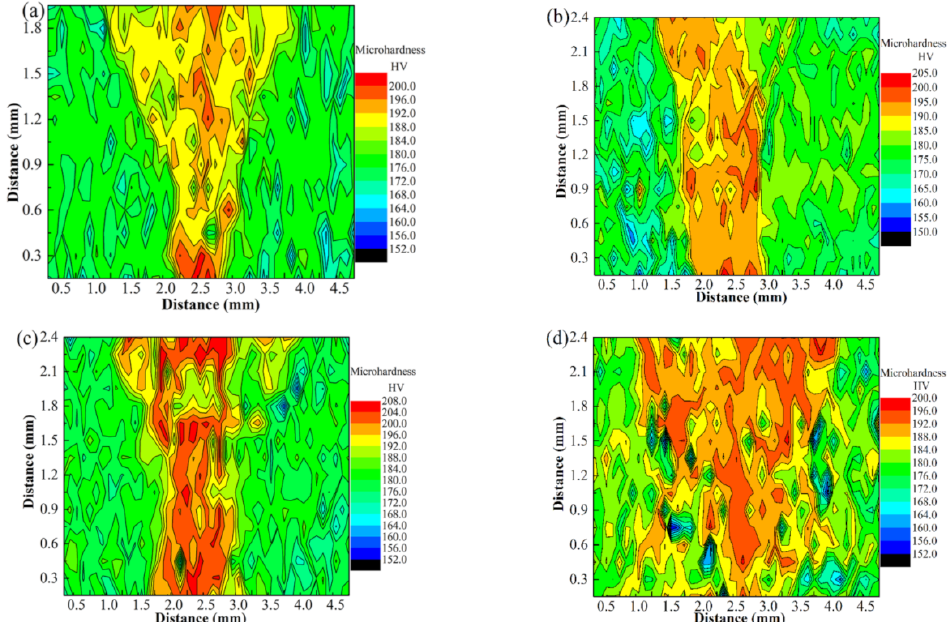
Figure 12. The microhardness distribution maps of the CoCrCuFeNi HEA welded joint, in which ( a – d ) correspond to samples 1.65–1.95 kW, respectively.